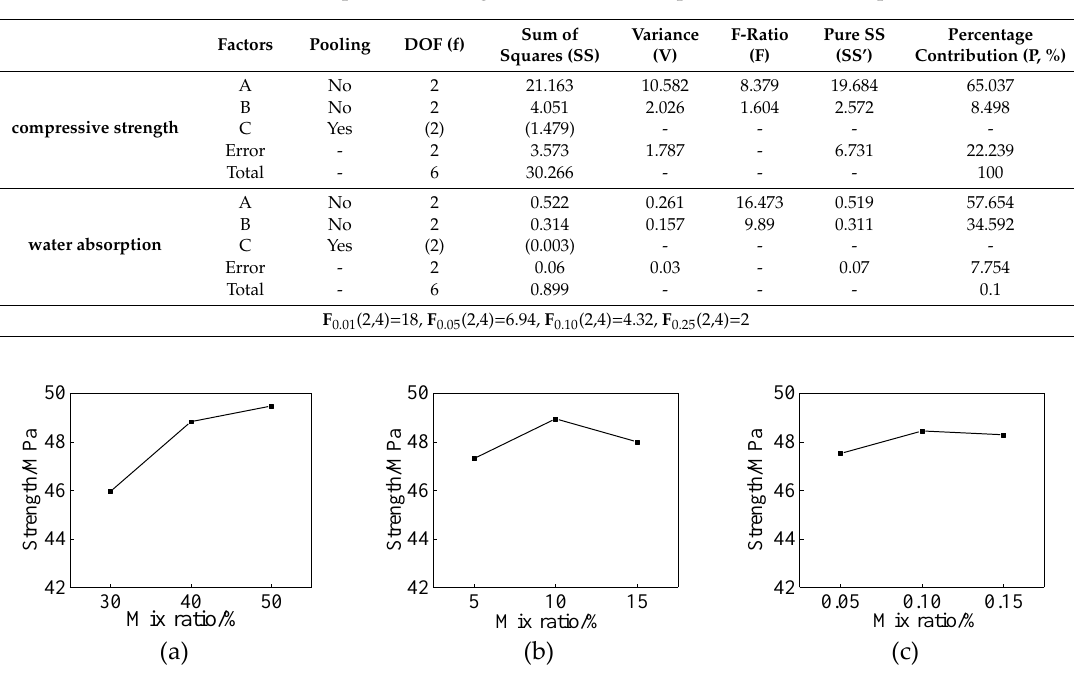
Table 5. ANOVAfor compressive strength and water absorption of the coated specimens.